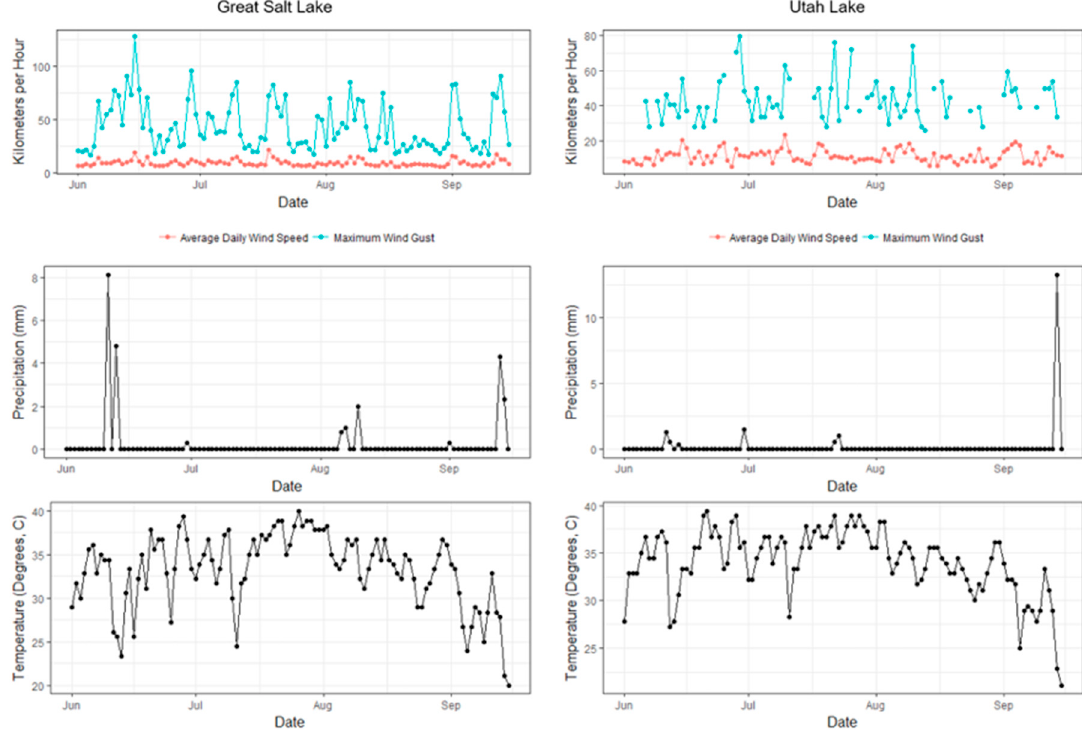
Figure 9. Daily Wind, Precipitation, and Temperature Records near the Great Salt Lake (GSL) and Utah Lake over the Period of Data Collection.